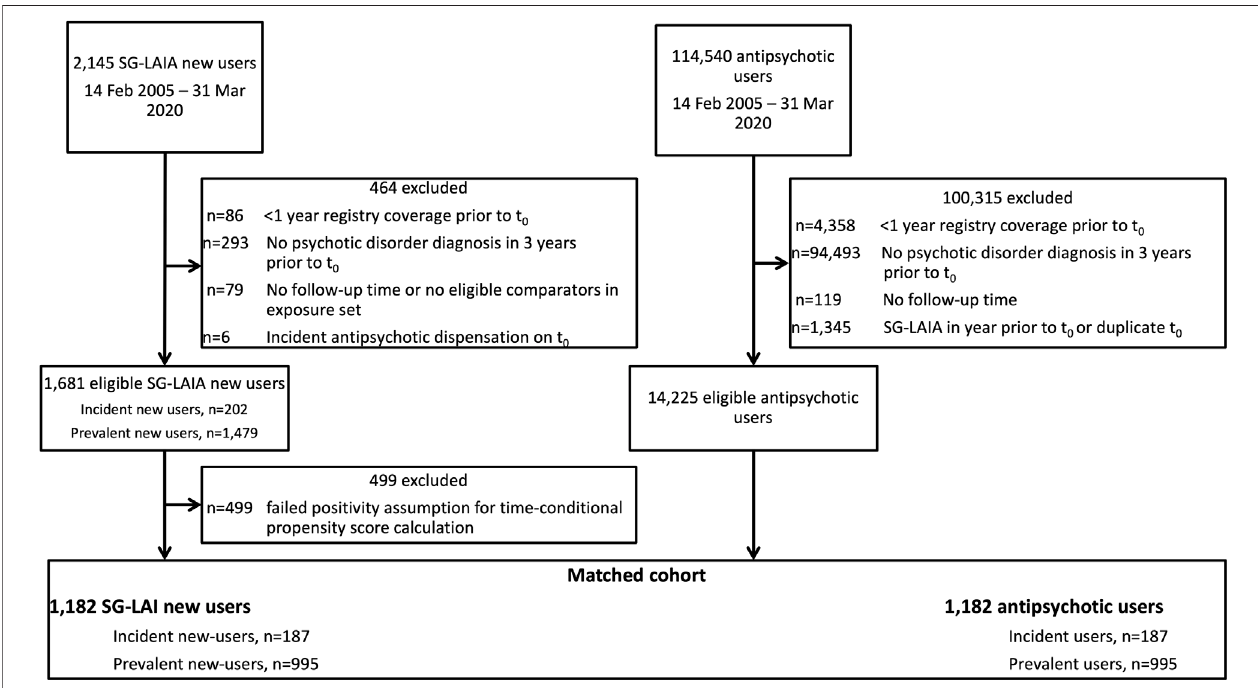
FIGURE 1 | Cohort